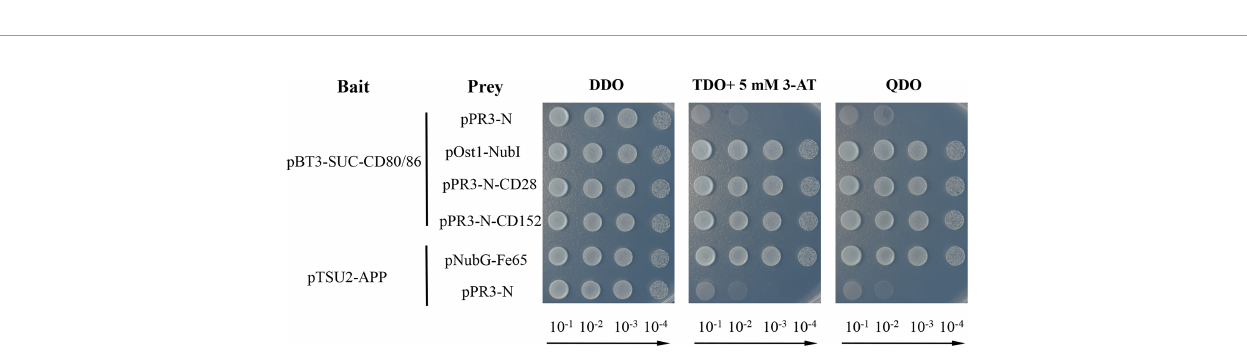
FIGURE 9 | Yeast two-hybrid assay of the interaction between CD80/86 and either CD28 or CD152. The pPR3-N and pBT3-SUC-CD80/86 plasmids were co- transformed into NMY51 yeast cells as the self-activation control. The pOst1-NubI and pBT3-SUC-CD80/86 plasmids were co-transformed into NMY51 yeast cells as a functional assay control. The two experimental groups, the pBT3-SUC-CD80/86 and pPR3-N-CD28 plasmids, alongside the pBT3-SUC-CD80/86 and pPR3- N-CD152 plasmids, were both co-transformed into the NMY51 yeast cells. The pNubG-Fe65 and pTSU2-APP plasmids were used as a positive control in NMY51 yeast cells, while pPR3-N and pTSU2-APP acted as the negative control. Following co-transformation, the yeast cells were inoculated on plates with double dropout medium (DDO: SD/ − Leu/ − Trp), triple dropout medium/3-AT (TDO/3-AT: SD/ − Leu/ − Trp/ − His, supplemented with 5 mM 3-Aminotriazole), and quadruple dropout medium (QDO: SD/ − Leu/ − Trp/ − His/ − Ade). The successful plasmid transfection was indicated by positive yeast clones on the DDO plates. The presence of clones on the TDO/3-AT plates signi fi ed the successful expression of the His3 reporter gene, while the presence of clones on the QDO denoted the successful